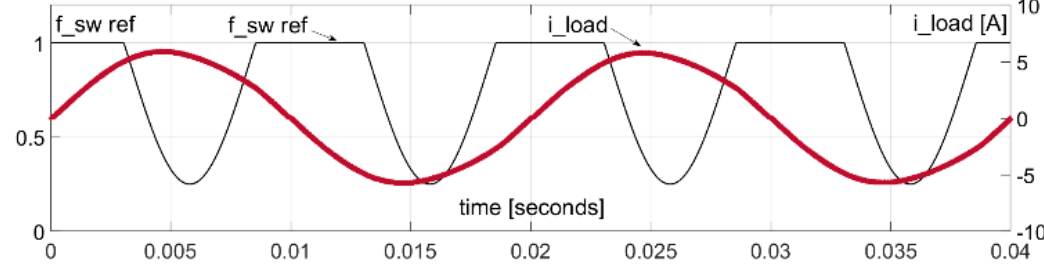
Figure 12. Reference switching frequency for the AIVB with the output current.